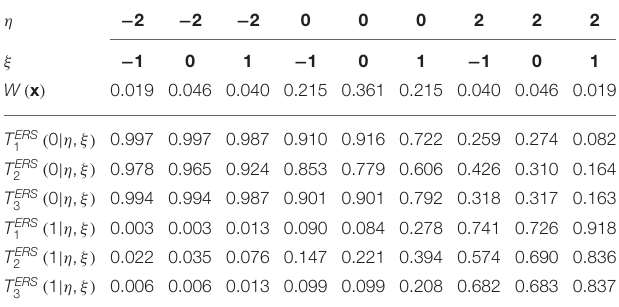
TABLE 6 | Ordinates of recoded category response functions and quadrature weights evaluated over the 3 × 3 direct product rectangular quadrature points for the three